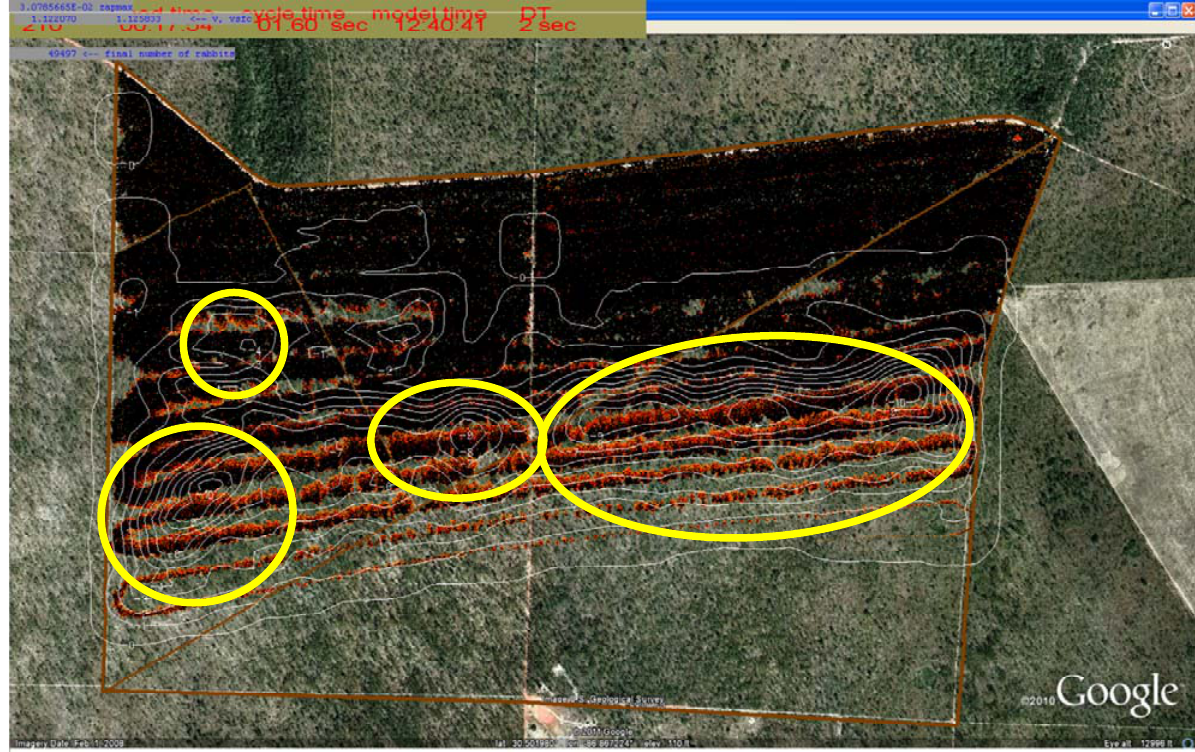
Figure 7. Pressure anomalies (white lines) generated by Rabbit Rules at 12:40:41. The yellow ellipses highlight centers that might correspond to updraft